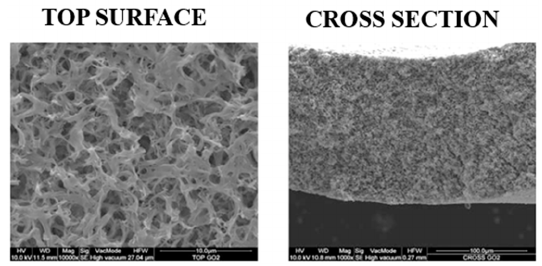
Figure 6. M10 SEM images. Magnification: top surface 10,000×, cross section 1000×.